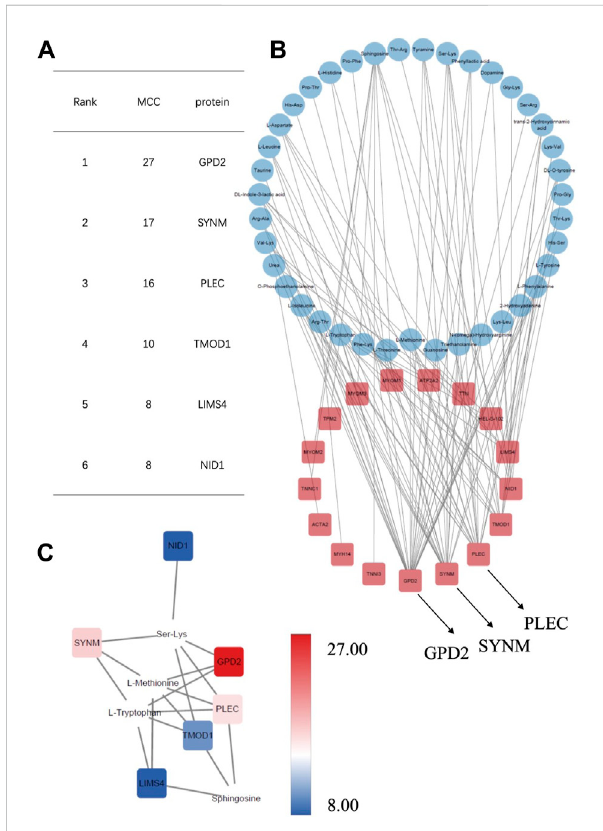
FIGURE 5 Correlation analysis of the differentially expressed proteins with metabolites in positively-ionized mode.